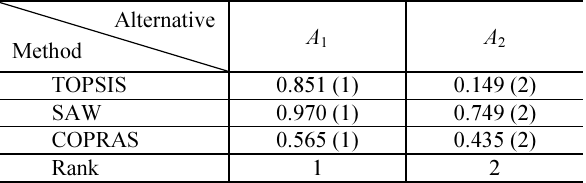
Table 3. Aggregated results of analyzed